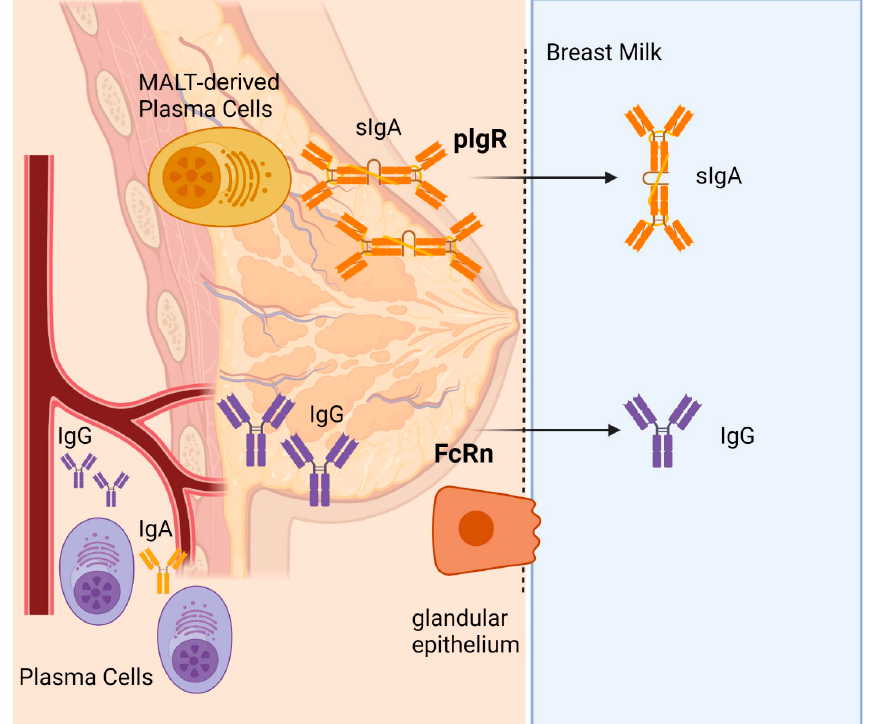
Figure 5. Transfer of Immunoglobulins (Igs) to the breast milk. Mucosa-associated lymphoid tissue (MALT)-derived plasma cells arise from mucosal tissues of both gut and airways and home to the mammary gland. These plasma cells produce secretory IgA (sIgA), which are passed into breast milk via the polymeric Ig receptor (pIgR) present on the mammary epithelium. IgG originating from secondary lymphoid organs and bone-marrow-derived plasma cells are transferred from the blood to the breast milk via neonatal Fc receptor (FcRn) expressed on the mammary epithelium cells.